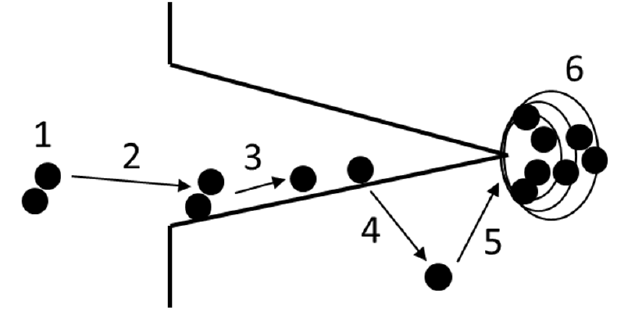
Figure 4. Rate-limiting steps for the transport of hydrogen to the fracture propagation zone. 1 = transport of hydrogen to the crack tip, 2 = physical adsorption, 3 = dissociative chemical adsorption, 4 = hydrogen absorption, 5 = transport of hydrogen to regions of tensile stress, 6 = hydrogen–material interactions.